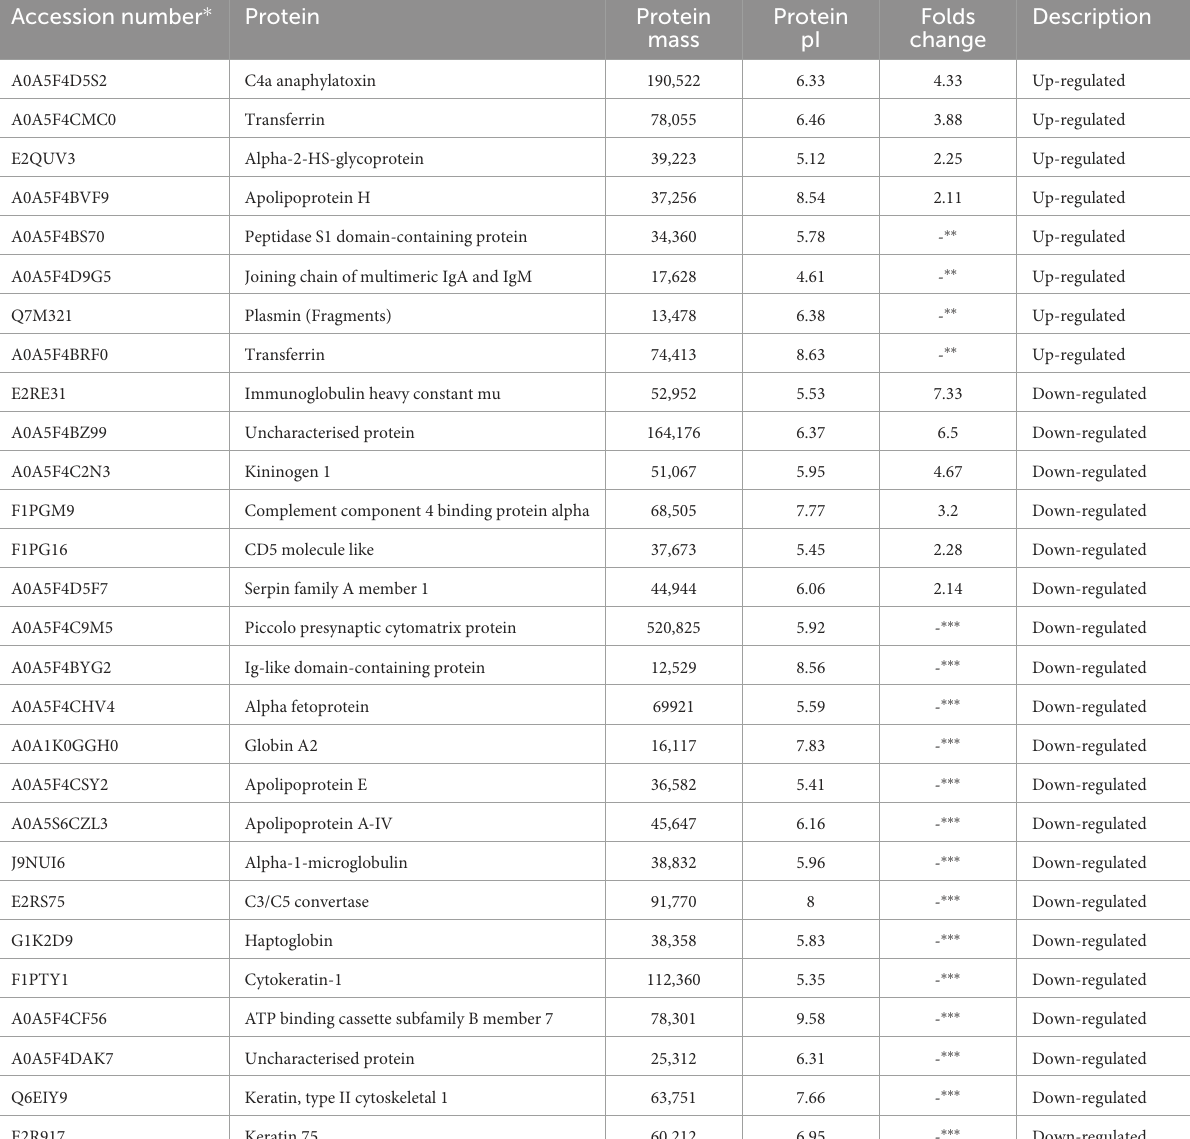
TABLE 1 Comparison of the protein fold change between the DM day 0 and healthy